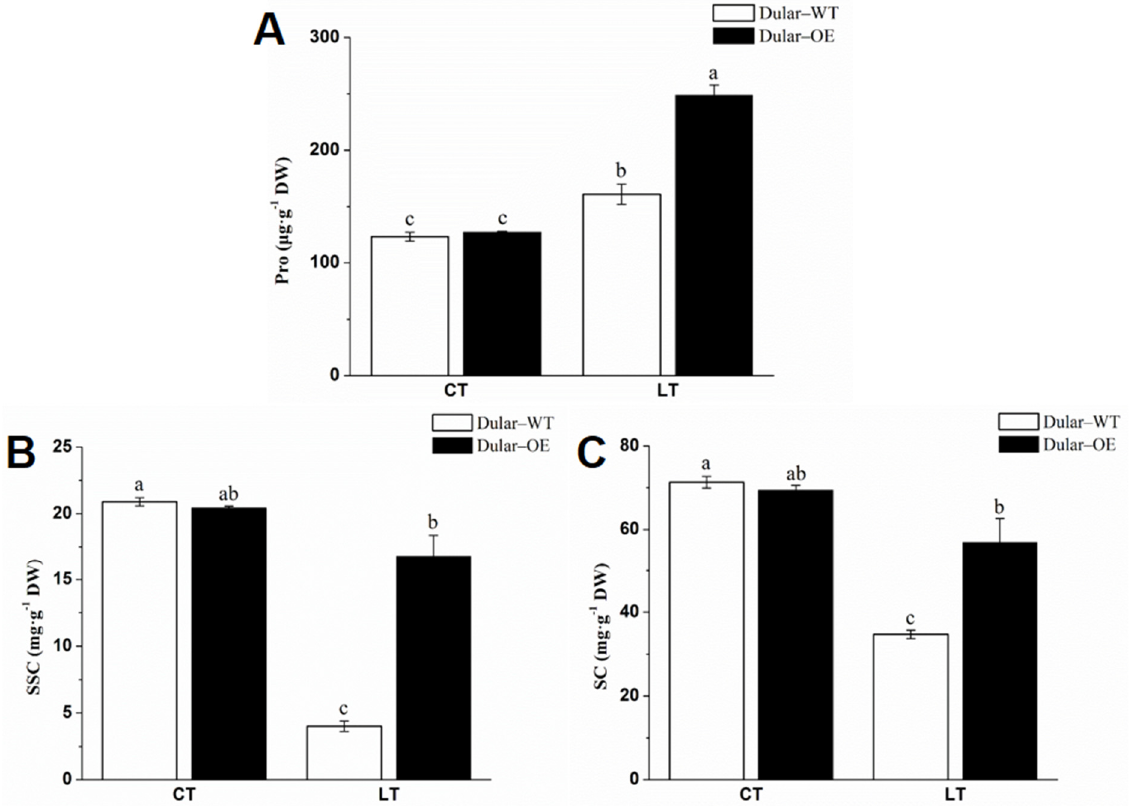
Figure 5. The non-structural carbohydrates and proline content in the rice leaves. ( A ) The proline content in the rice leaves. ( B ) The soluble sugar content in the leaves. ( C ) The starch content in the leaves. Columns with different letters are significantly different (LSD test, p < 0.05). Error bars are the standard error (±SE) of three biological replications. DW: dry weight; CT: normal temperature; LT: low temperature; SSC: soluble sugar content; SC: starch content.